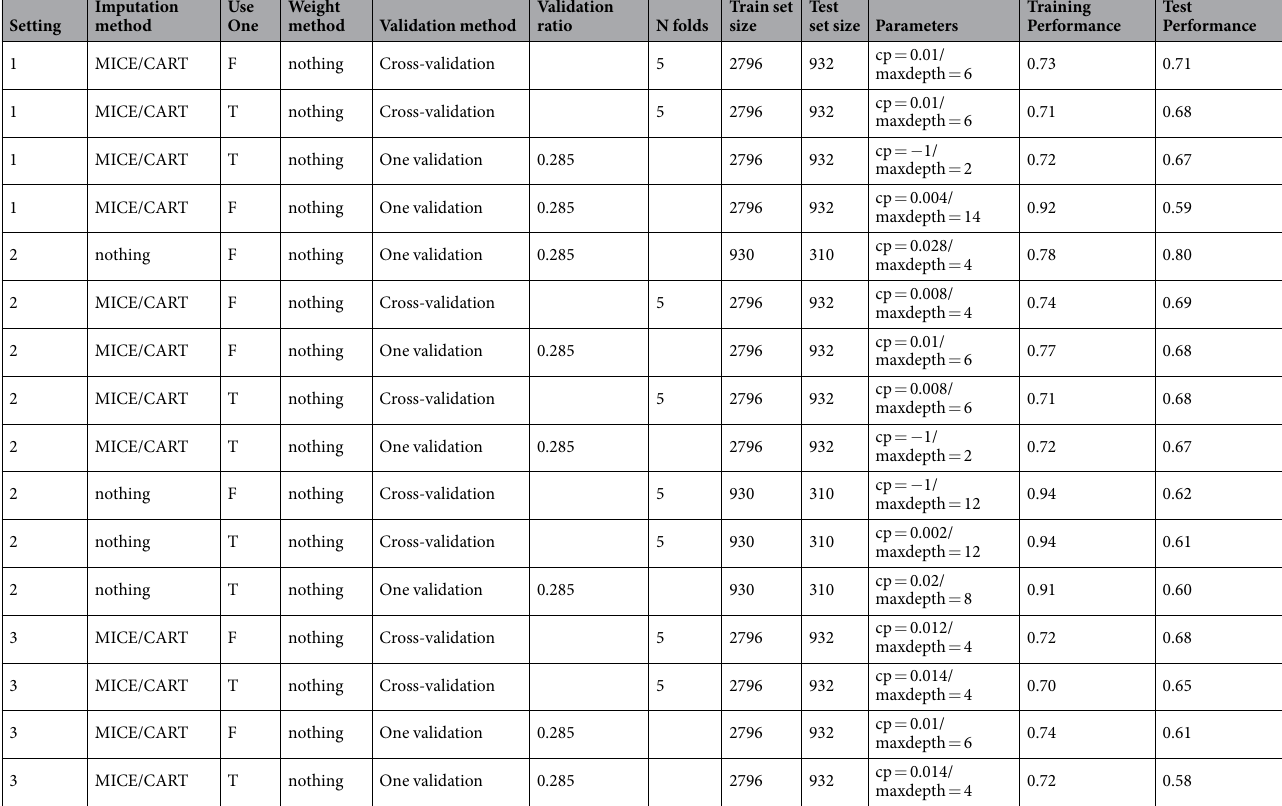
Table 5. Performance of the prediction model by survival hazard ratio decision tree using different model setting. * Test performance were presented as concordance index for time to graft failure data. Model